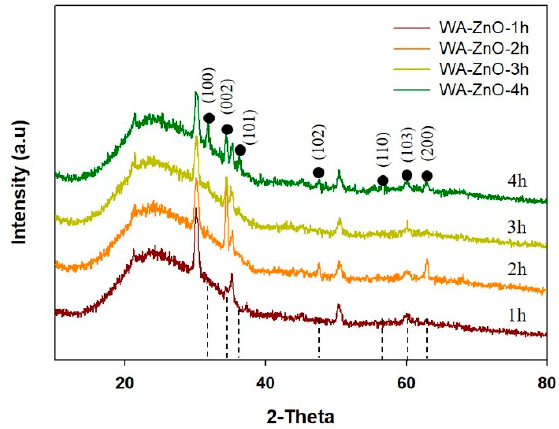
Figure 2. The X-ray diffraction pattern of WA-ZnO Nrods grown on the ITO substrate with various reaction time of 1 to 4 h.